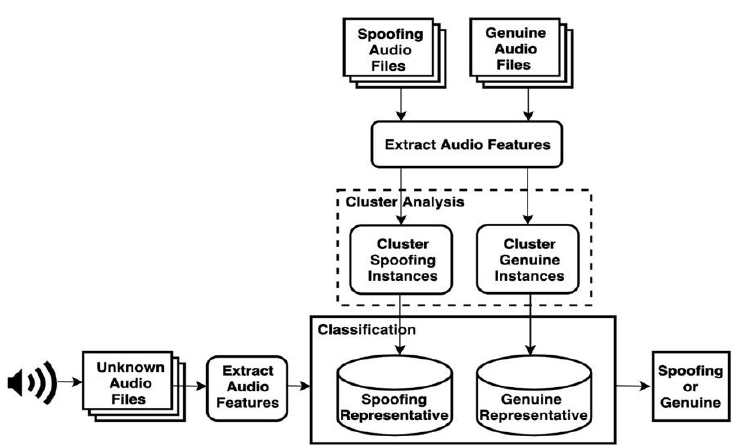
Figure 1. Architecture of the spoofing countermeasure based on mining hidden partitions of genuine and spoofed utterances